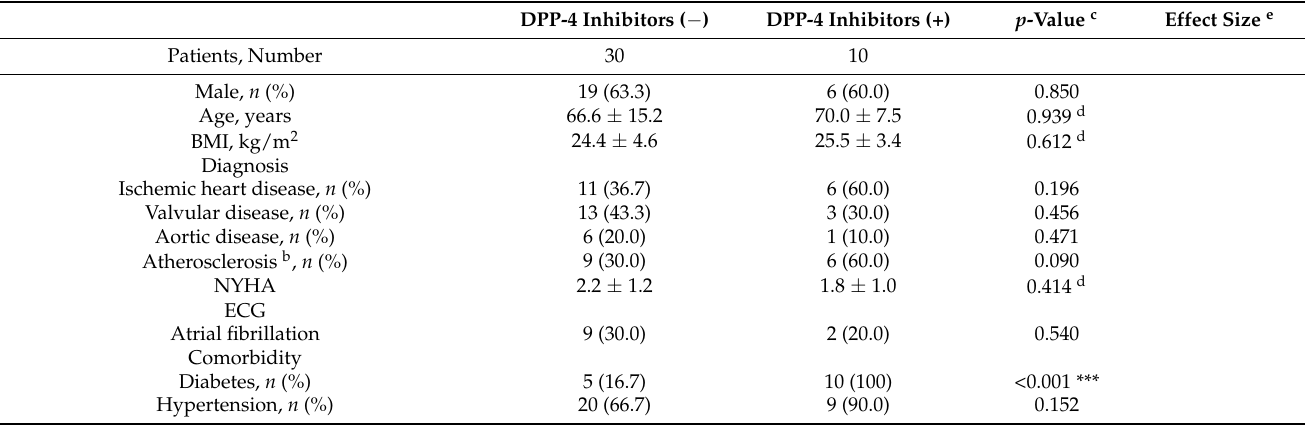
Table 4. Characteristics of patient groups taking DPP-4 inhibitors and those not taking